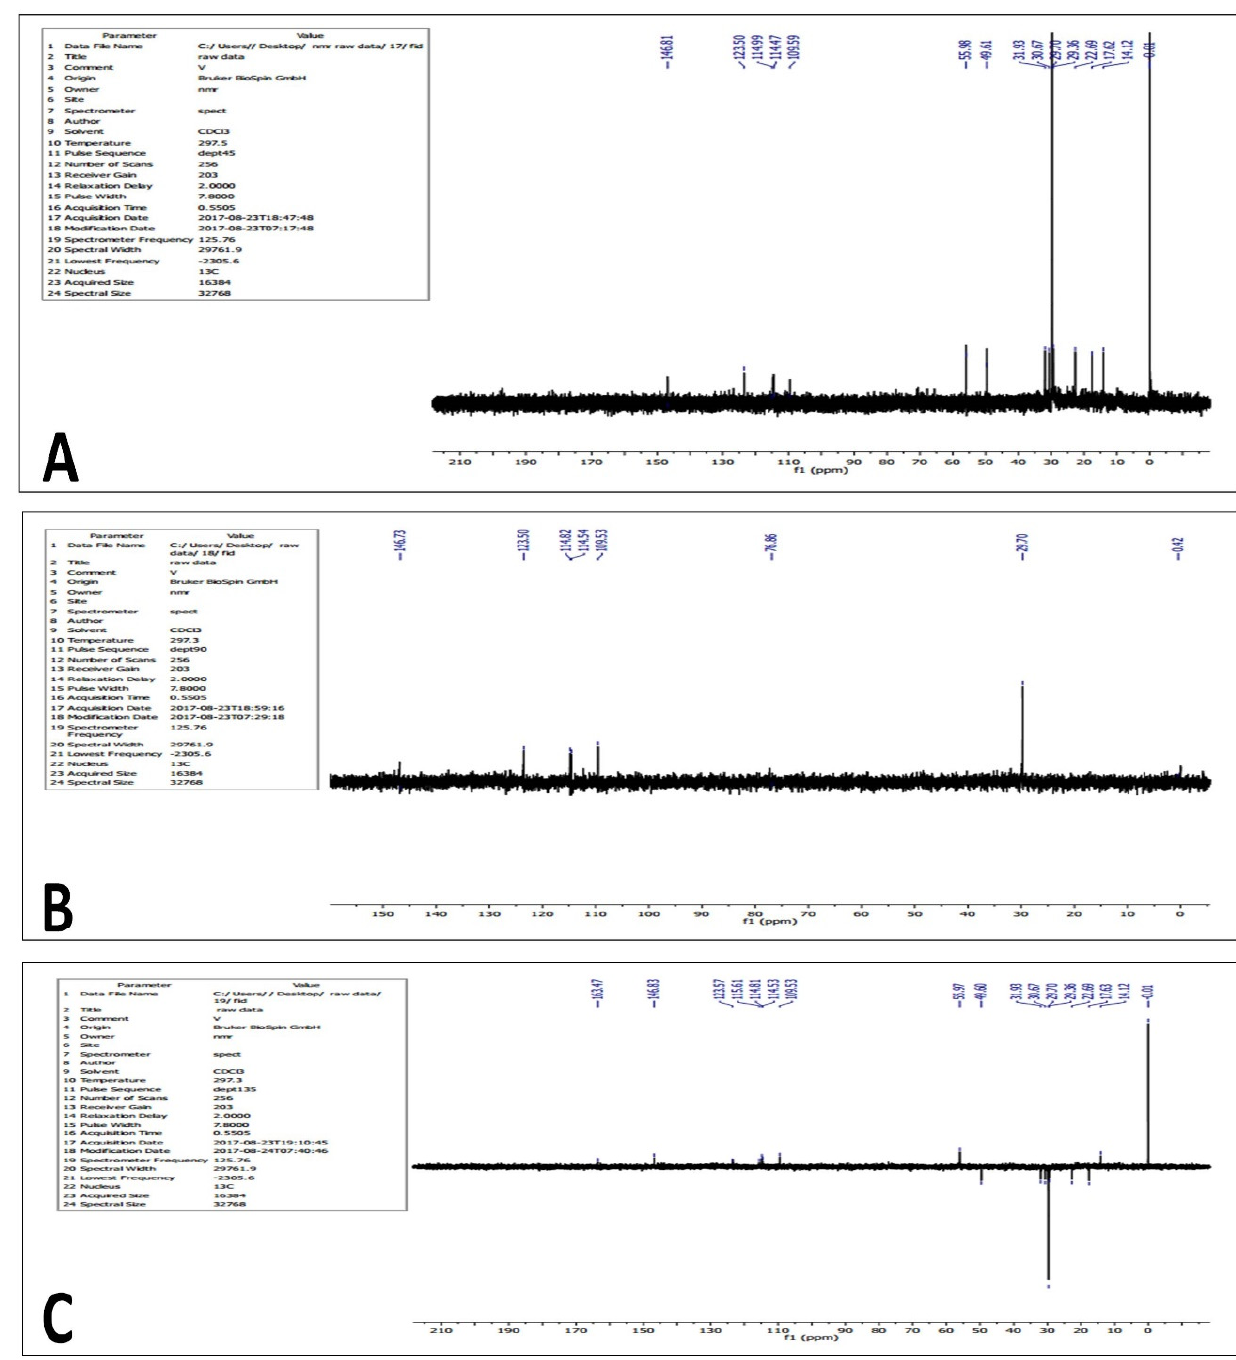
Figure 9. DEPT 45 ( A ), 90 ( B ) and 135 ( C ) NMR analysis of the purified compound from the extracts of Leucas indica flowers.